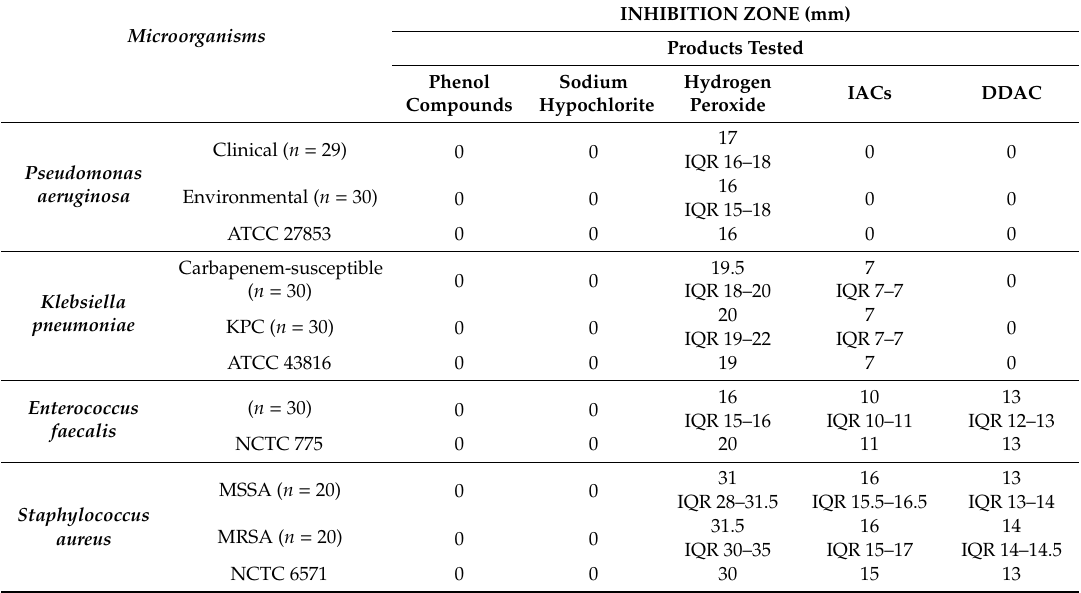
Table 2. Median and interquartile range (IQR) of the inhibition zones (mm) generated by the products tested against all tested bacteria and standard microorganism